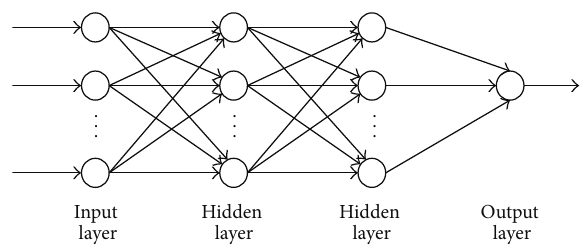
Figure 2: The architecture of the